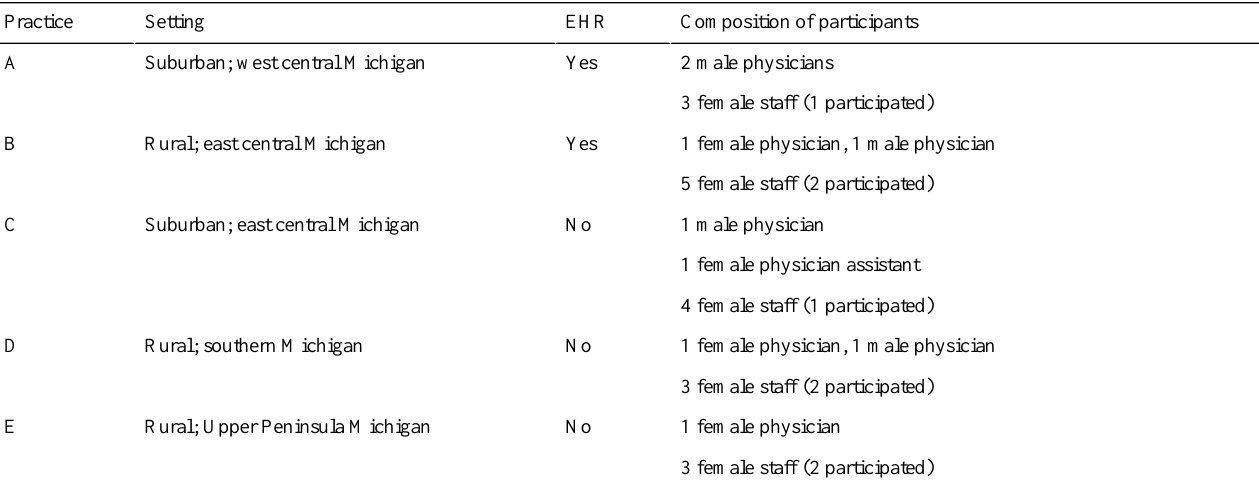
Table 2. Characteristics of the participating practice settings, EHR use, and focus group participants’professional status and